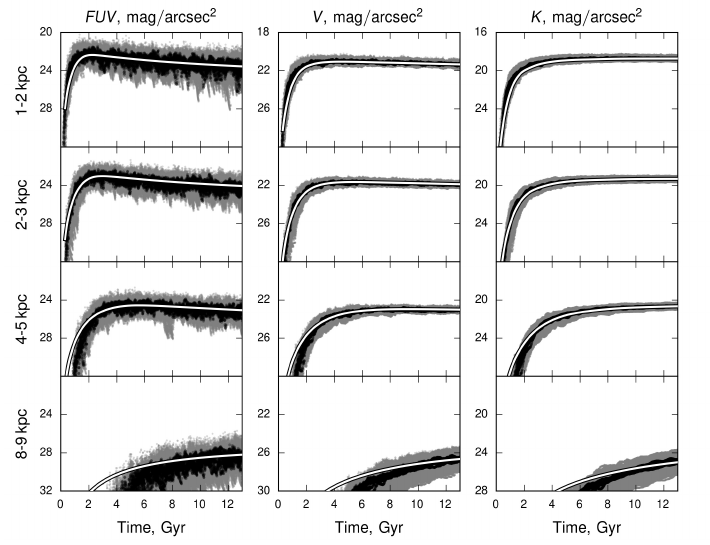
Fig. 8. The same as in Fig. 7, but for the HS